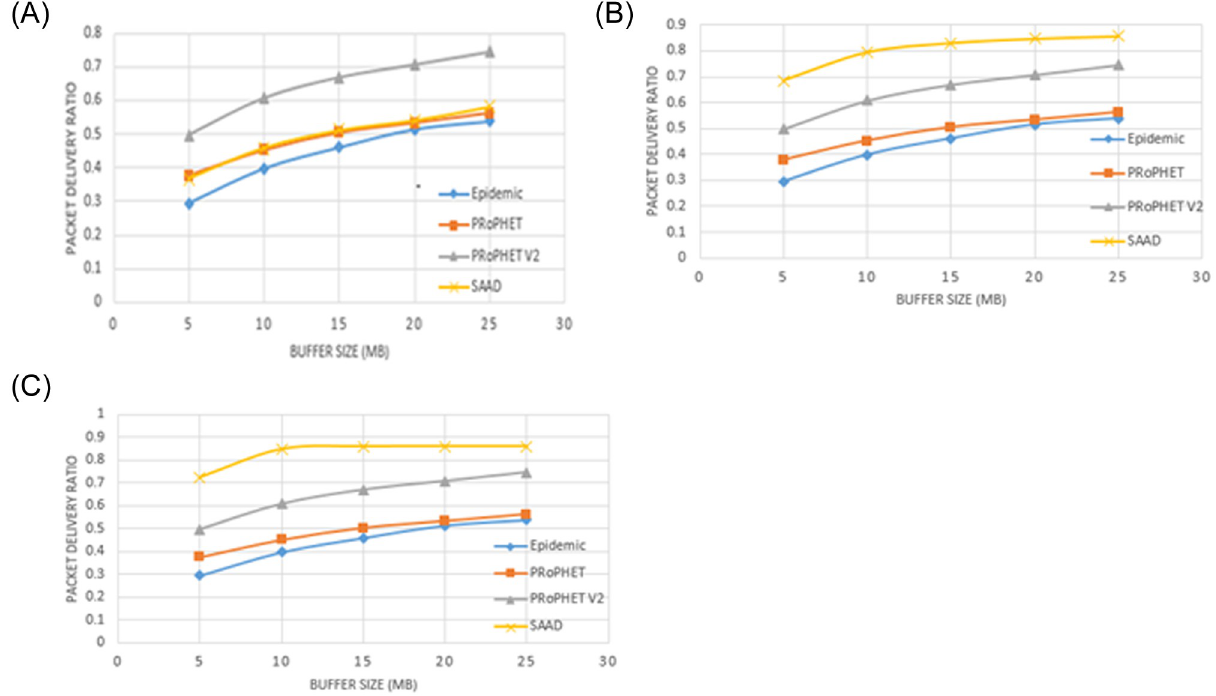
Fig 5. A. Packet Delivery Ratio with different buffer capacity and DC (threshold = 0). B. Packet Delivery Ratio with different buffer capacity and DC (threshold = 2). C. Packet Delivery Ratio with different buffer capacity and DC (threshold = 4).